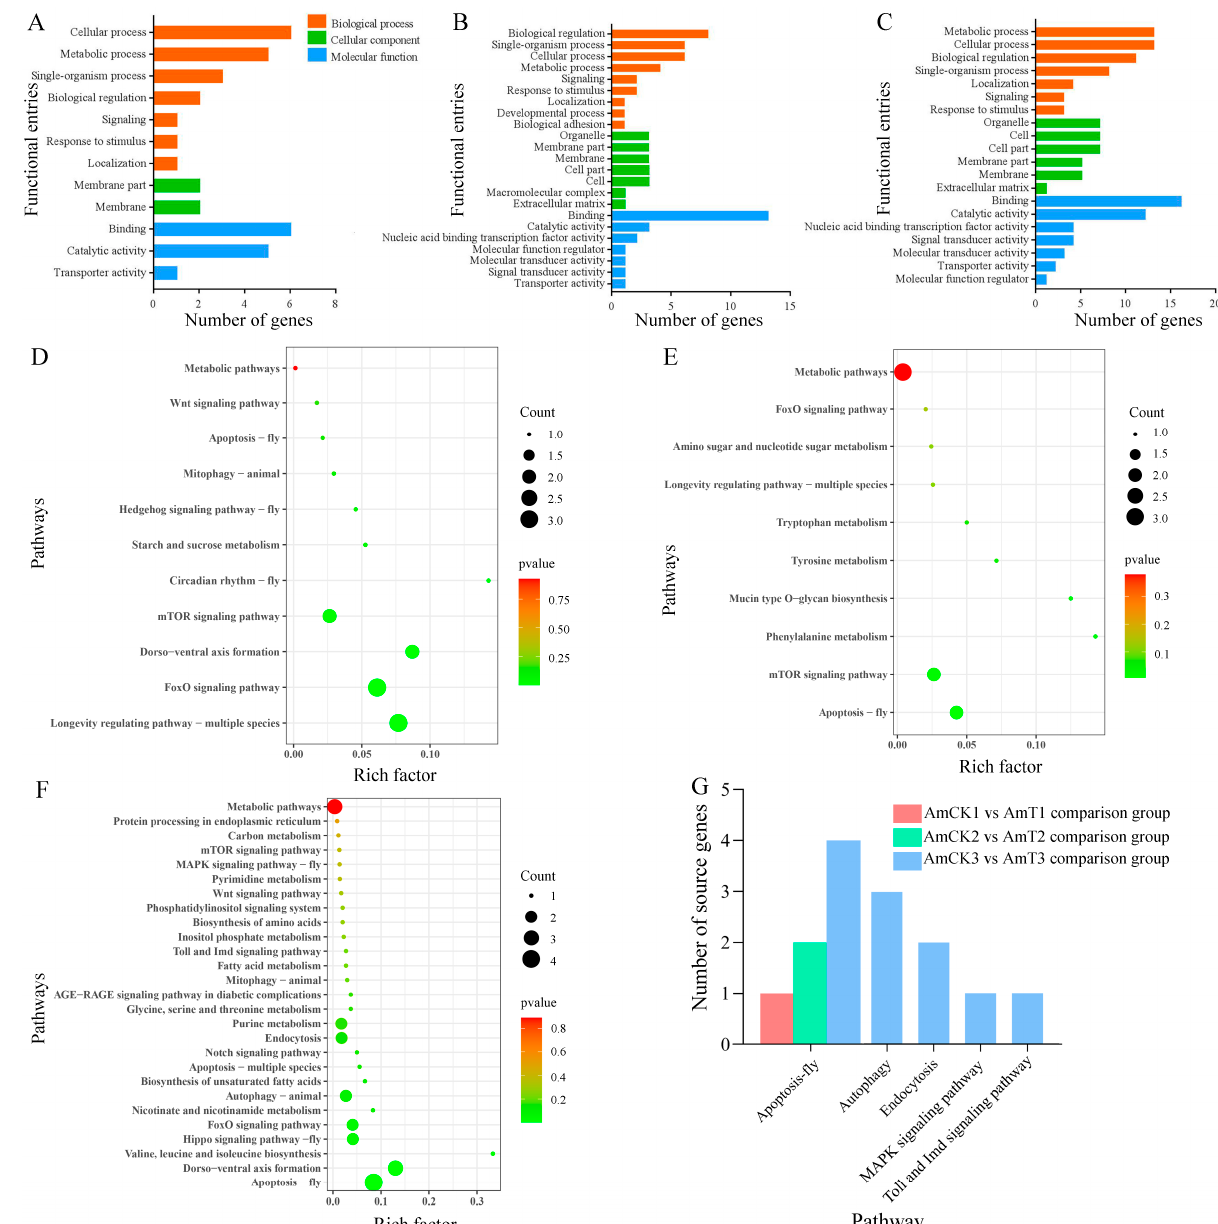
Figure 3. Annotations of the source genes of the DEcircRNAs in the three comparison groups: ( A – C ) GO database annotations of the source genes; ( D – F ) KEGG database annotations of the source genes; ( G ) number statistics of the source genes related to cellular and humoral immune pathways.